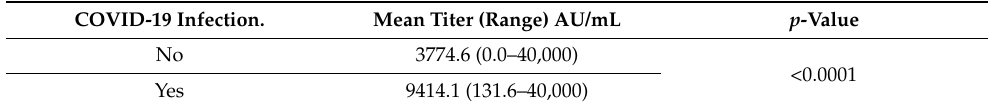
Table 4. The effect of COVID-19 infection on the mean titer of neutralizing IgG antibodies in vaccinated HCWs regardless of the type of vaccine and the time of infection.